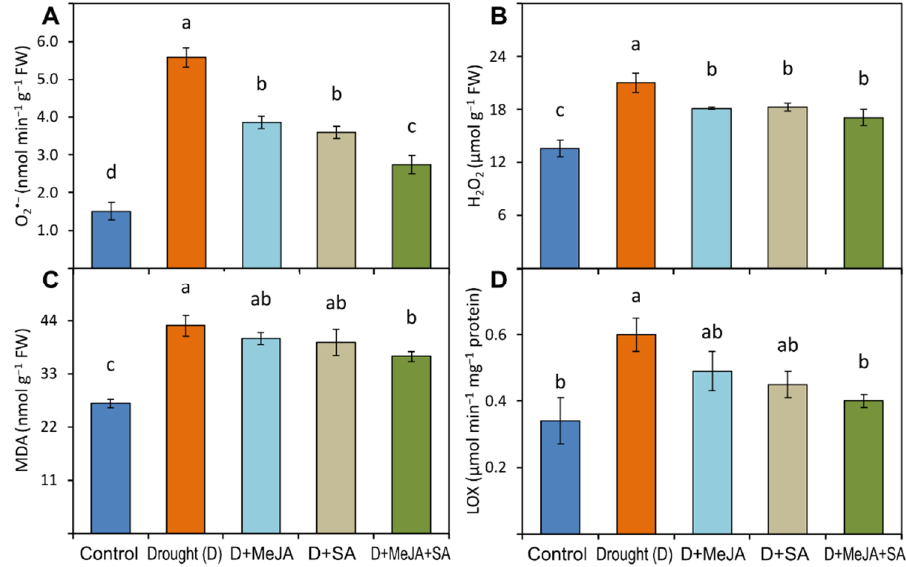
Figure 4. ( A ) superoxide (O 2 •− ) generation rate; ( B ) hydrogen peroxide content (H 2 O 2 ); ( C ) malondialdehyde content (MDA); ( D ) lipoxygenase (LOX) activity of French bean plants grown under control, drought (D), and drought-stressed plants treated with methyl jasmonate (D + MeJA), salicylic acid (D + SA), and their combination (D + MeJA + SA). Vertical bars represent +/− SE values. Different letter(s) denote a significant difference at p ≤ 0.05. FW—Fresh weight. Additional details are shown in Figure 1.